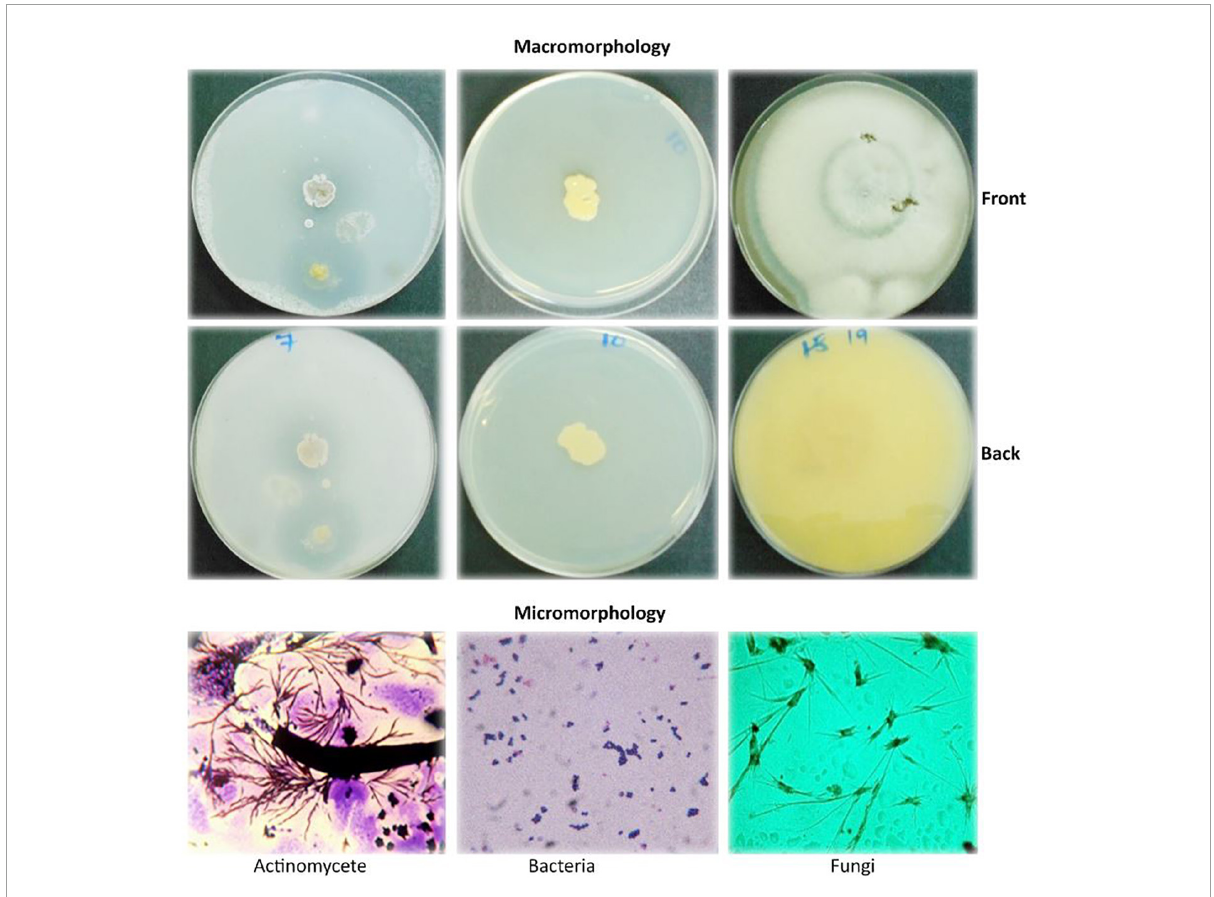
FIGURE1 Macromorphological and micromorphological characteristics of the actinomycetes, bacteria, and fungi studied for the degradation of plastics.